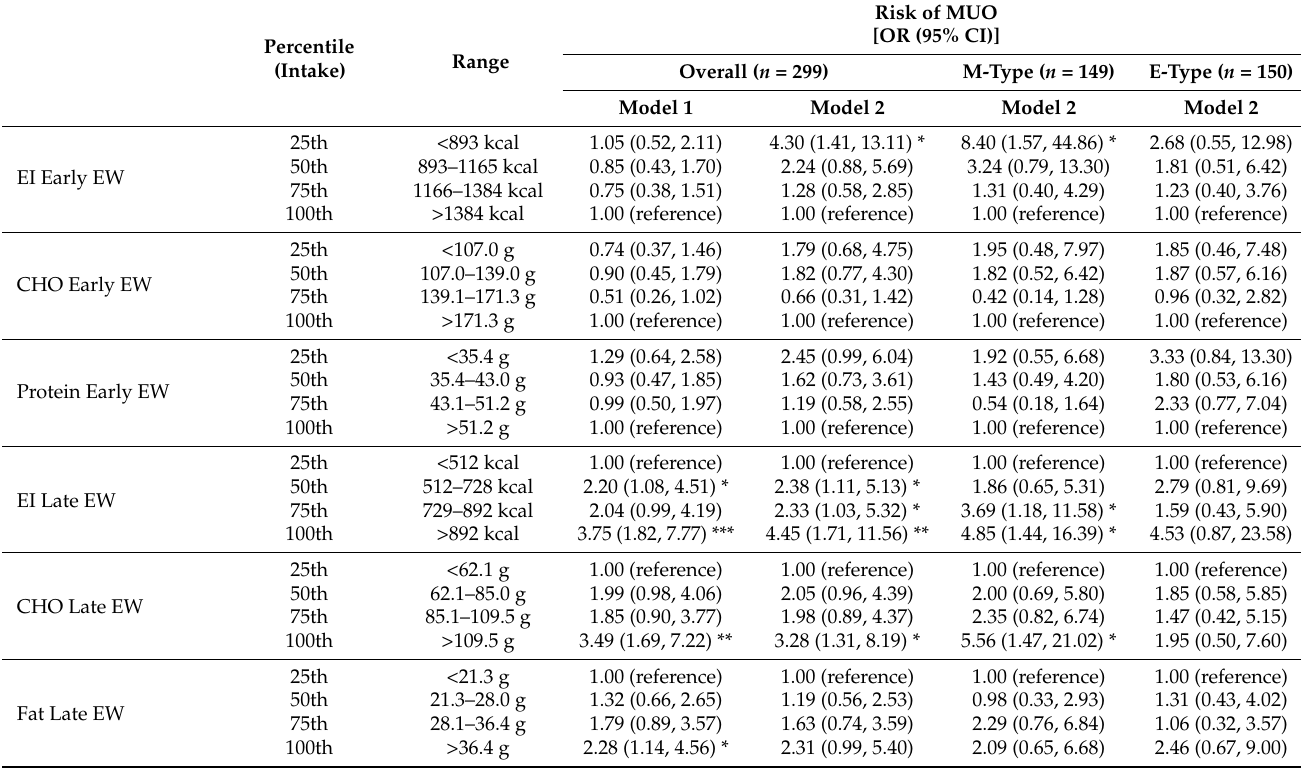
Table 4. The temporal patterns of energy and macronutrient intake associated with